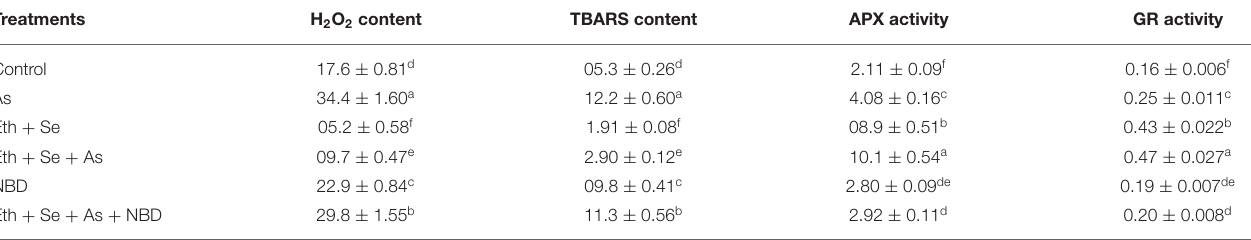
TABLE 5 | The H 2 O 2 content (nmol g − 1 FW), TBARS content (nmol g − 1 FW), APX activity (U mg − 1 protein min − 1 ), and GR activity (U mg − 1 protein min − 1 ) of mustard plant ( B. juncea L.) grown with 200 µ l L − 1 Eth and/or 2-mg Se kg − 1 soil in the presence or absence of 24-mg As kg − 1 soil at 30 DAS.